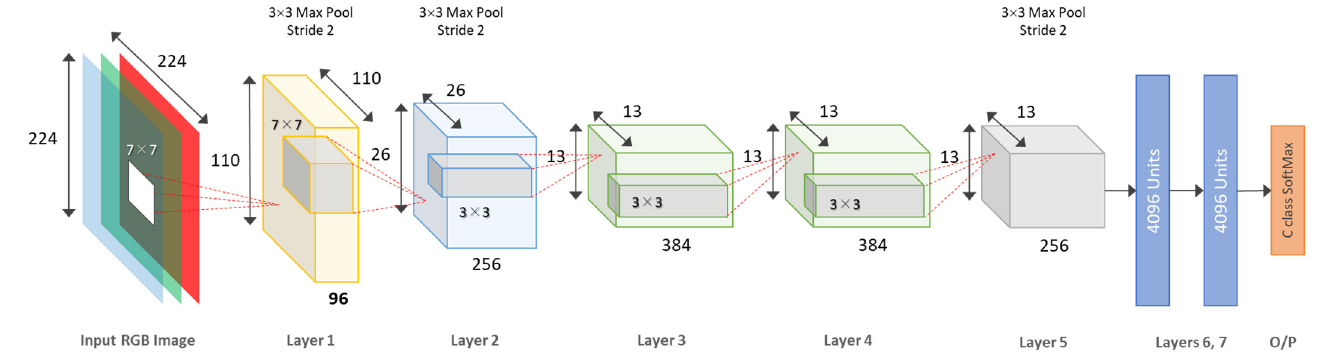
Figure 2. The architecture of ZFNet deep learning network, consisting of 8 covnet layers. A 224 × 224 image is presented as the input, while the final layer is a C-way SoftMax (C = 2).